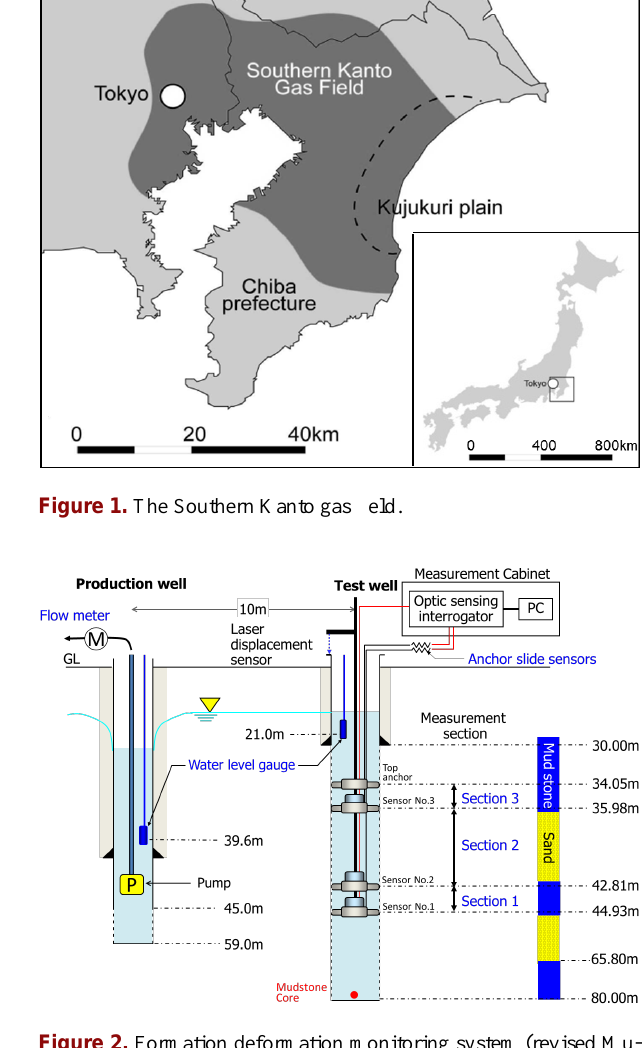
Figure 2. Formation deformation monitoring system (revised Mu- rai et al., 2013).